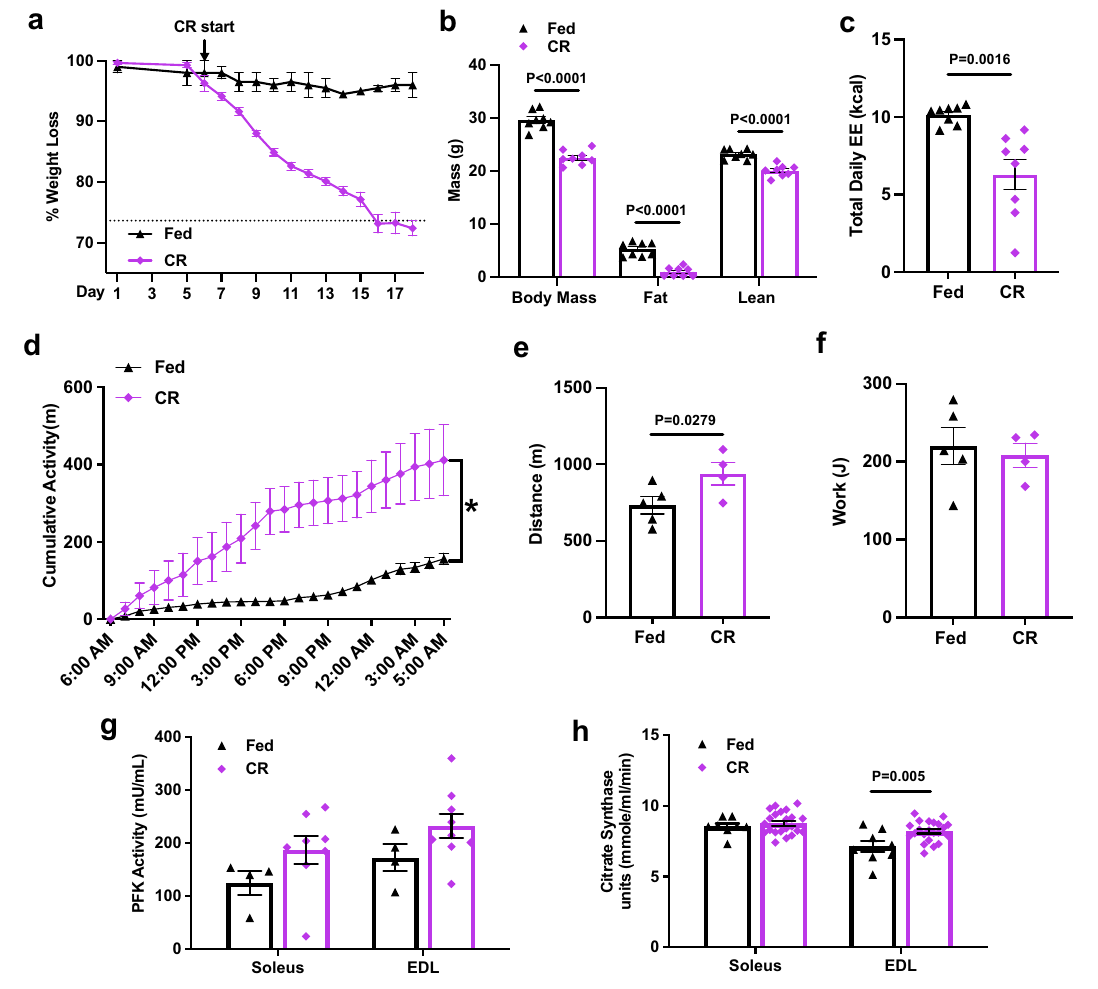
Fig. 3 | Caloric Restriction does not recapitulate the metabolic changes observed in CACS. Wild-type mice were calorie restricted (CR) by feeding a ~8kcal/day diet (amount consumed by cachectic mice) until weight stabilization. a Percent ofbodyweight change overaperiod of18 daysof CR( n =8),or control diet (Fed, n =2); The dashed line on the y-axis re fl ects the mean calorie con- sumption of mice with CACS taken from Fig. 1b. b Total body weight, Fat, and Lean mass of Fed ( n =8) and CR( n =8) mice of a at day 18. c Total daily energy expenditure (kcal) in 24h of Fed ( n =8) and CR( n =8). d Cumulative activity (distance traveled in meters) over a representative 24h period of Fed( n =8) and CR mice( n =8). e Distance traveled (m) and (F) Work (J) performed by Fed( n =5)